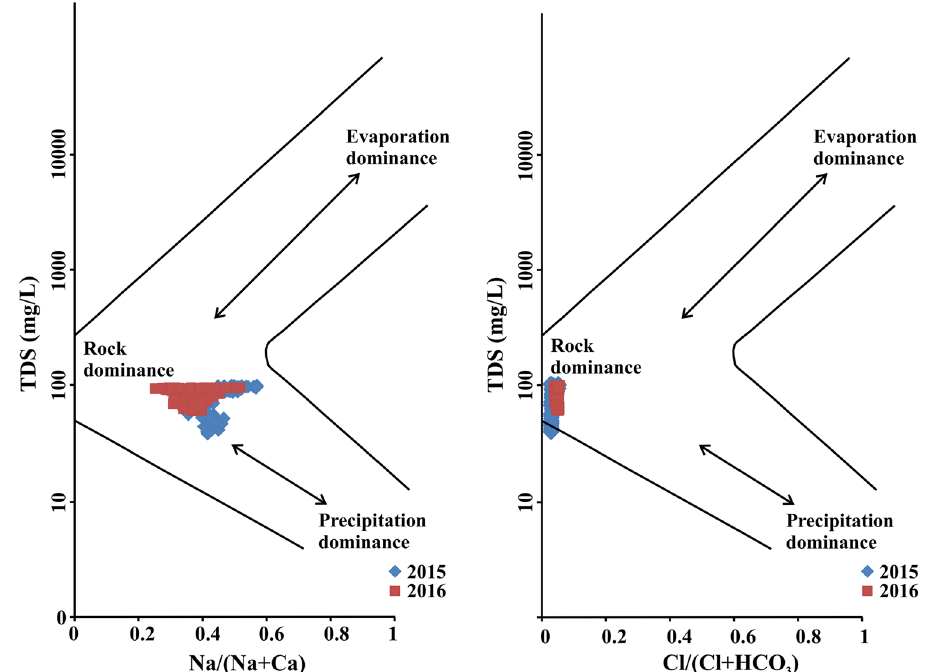
Fig. 10 Gibbs plots between Na/(Na + Ca) versus TDS and Cl/(Cl + HCO 3 ) vs TDS shows that rock weathering mainly control the solute